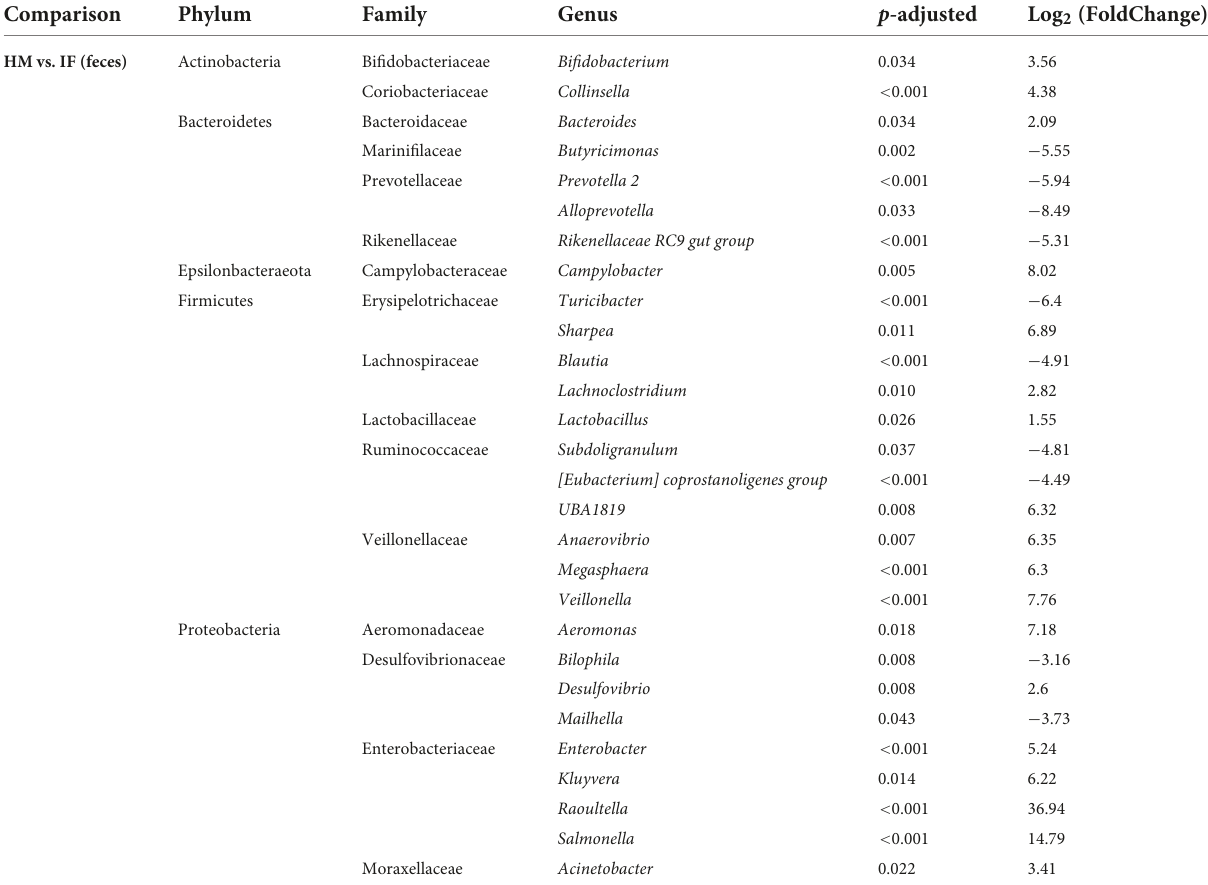
TABLE 3.2 Dietary impact on differential relative abundance of bacterial genera in feces of HM- and IF-fed piglets. Comparison